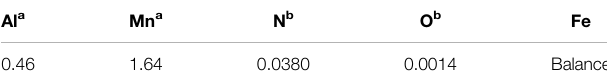
TABLE 1 | Initial chemical composition of FeAlMn alloy